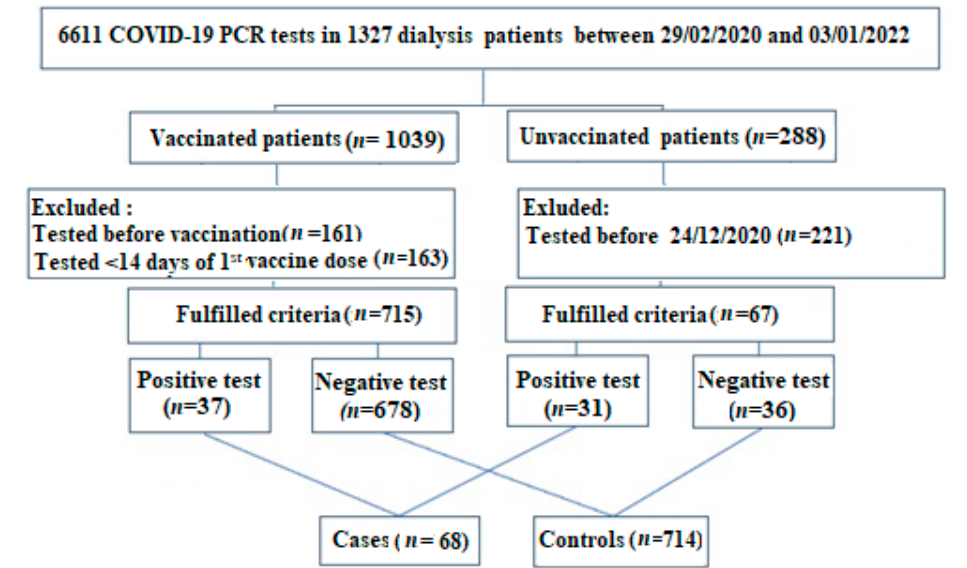
Figure 1. Flow chart of the study design.